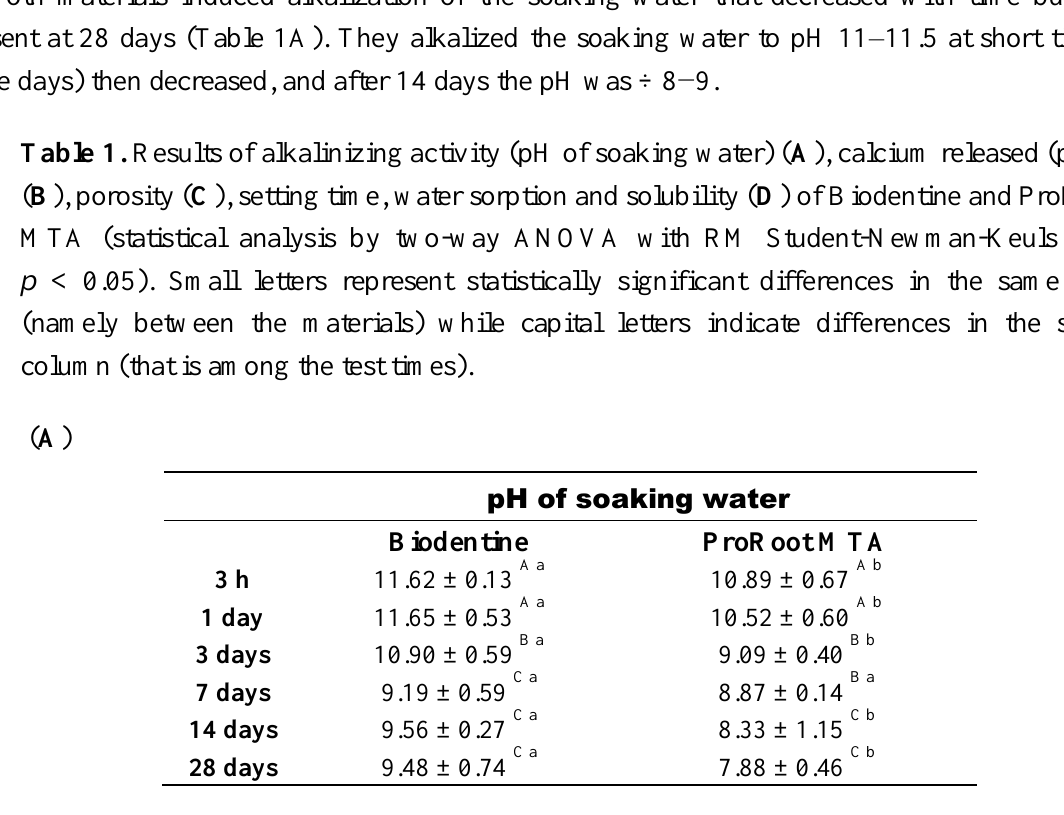
Table 1. Results of alkalinizing activity (pH of soaking water) ( A ), calcium released (ppm) ( B ), porosity ( C ), setting time, water sorption and solubility ( D ) of Biodentine and